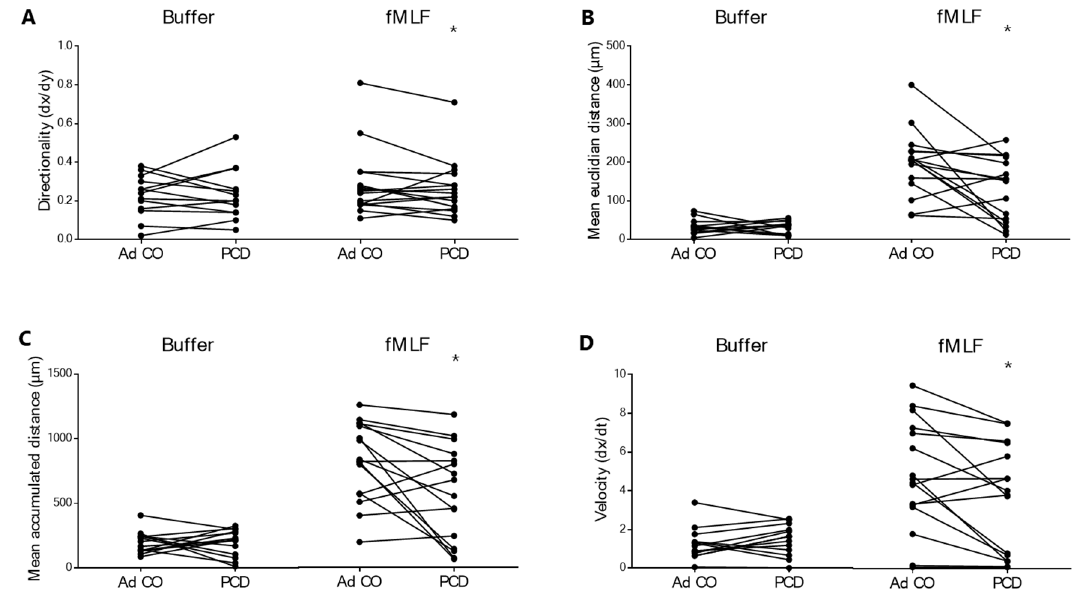
Figure 2. Decreased migratory capacity of blood PMNs from patients with PCD to fMLF in the µ-slide 2D chemotaxis assay. The chemotactic migration of PMNs from patients with PCD (PCD, n = 16 [10 pediatric and 6 adult]) and healthy adult controls (Ad CO, n = 16) to fMLF (10 − 8 M) was investigated. ( A ) The directionality, ( B ) mean Euclidian distance (µm), ( C ) mean accumulated distance (µm) and ( D ) velocity of PMNs from patients and Ad CO in response to buffer and fMLF were measured. For each experiment, the data obtained from the patient and the adult control tested on the same day are connected by a solid line. Statistical differences were determined by the non-parametrical pairwise Wilcoxon test (* p < 0.05).